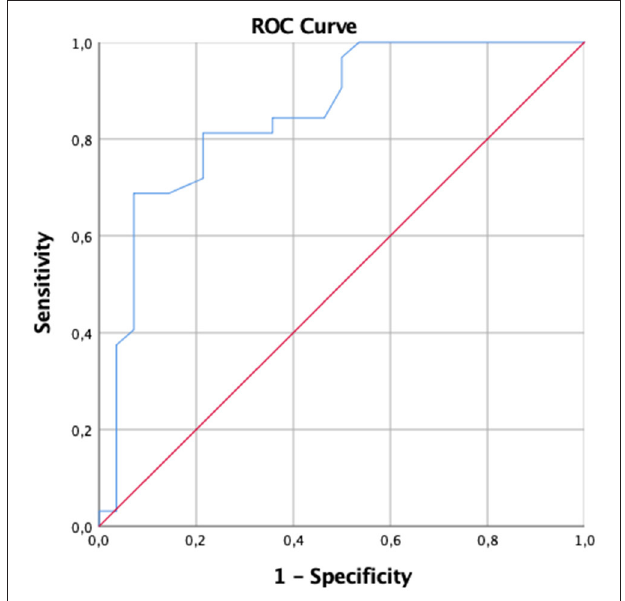
FIGURE 1 | Graphical representation of receiver operator characteristic curve of the PASS total score.